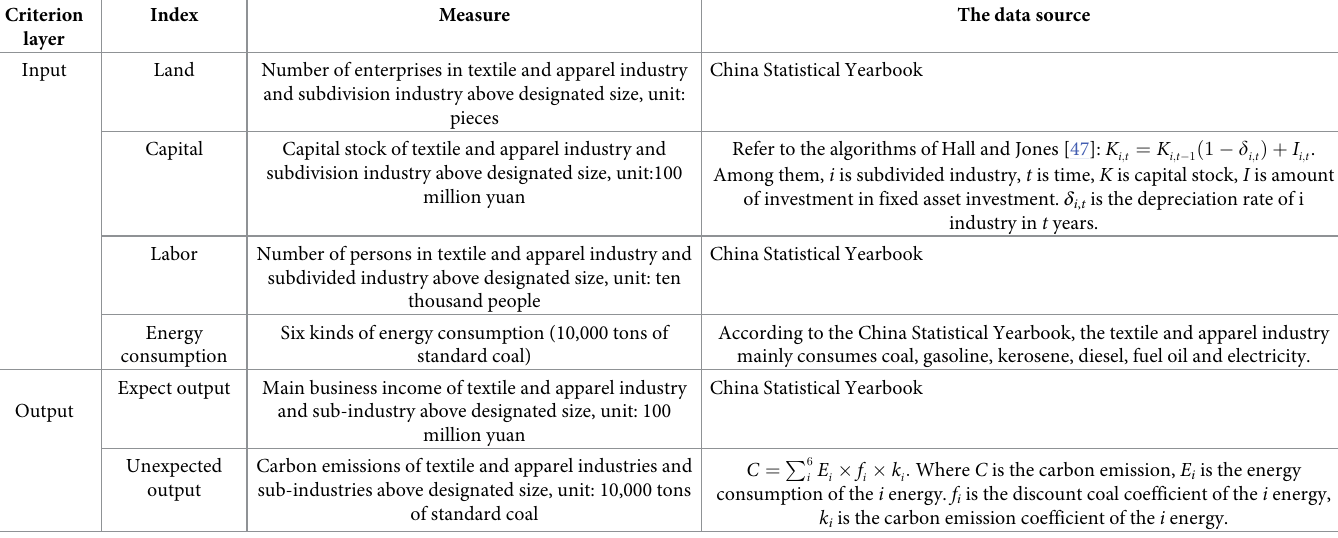
Table 1. Input-output variables of Green total factor